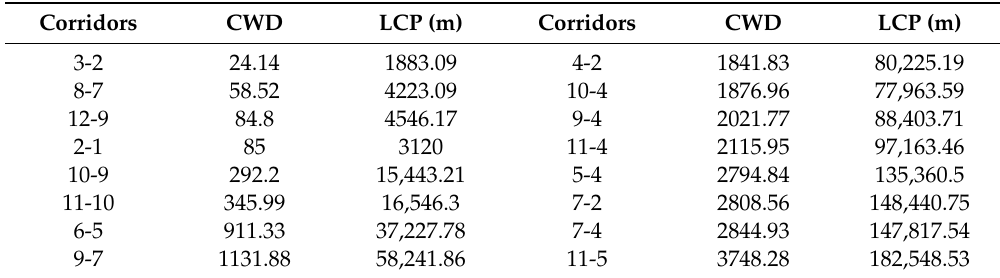
Table 6. Resistance and distance of potential corridors under ideal conditions, while CWD represents the cumulative resistance of corridors. LCP represents the length of corridors.